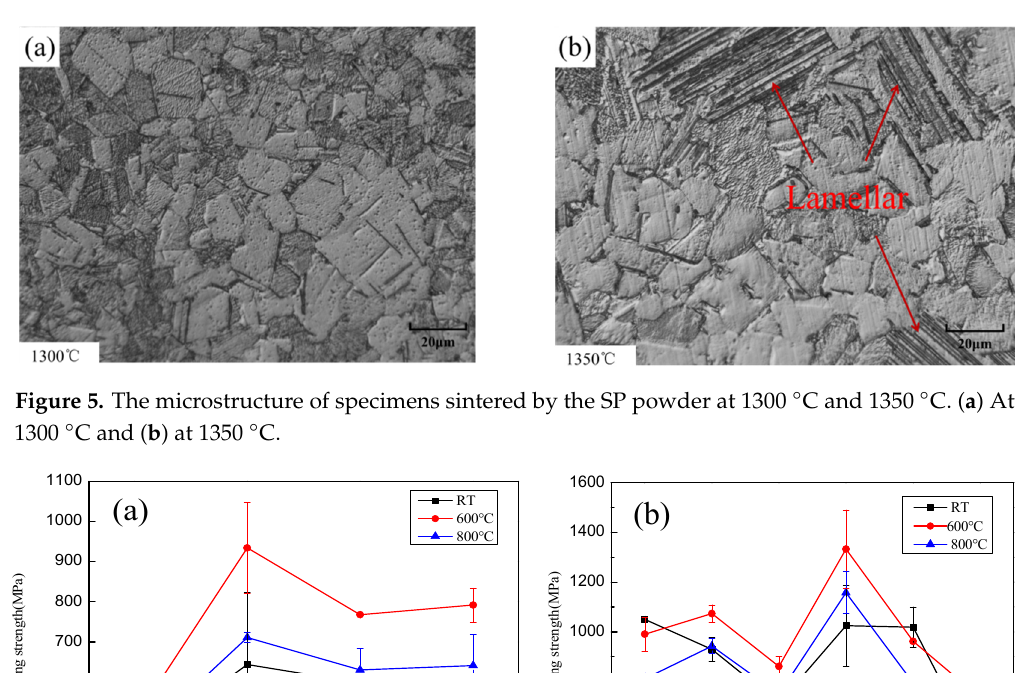
Figure 4. Density, Vickers hardness and average grain size of Ti-48Al-2Cr-8Nb alloy as a function of sintering temperature. ( a ) Density and ( b ) Vickers hardness and average grain size (densation greater than 97%).